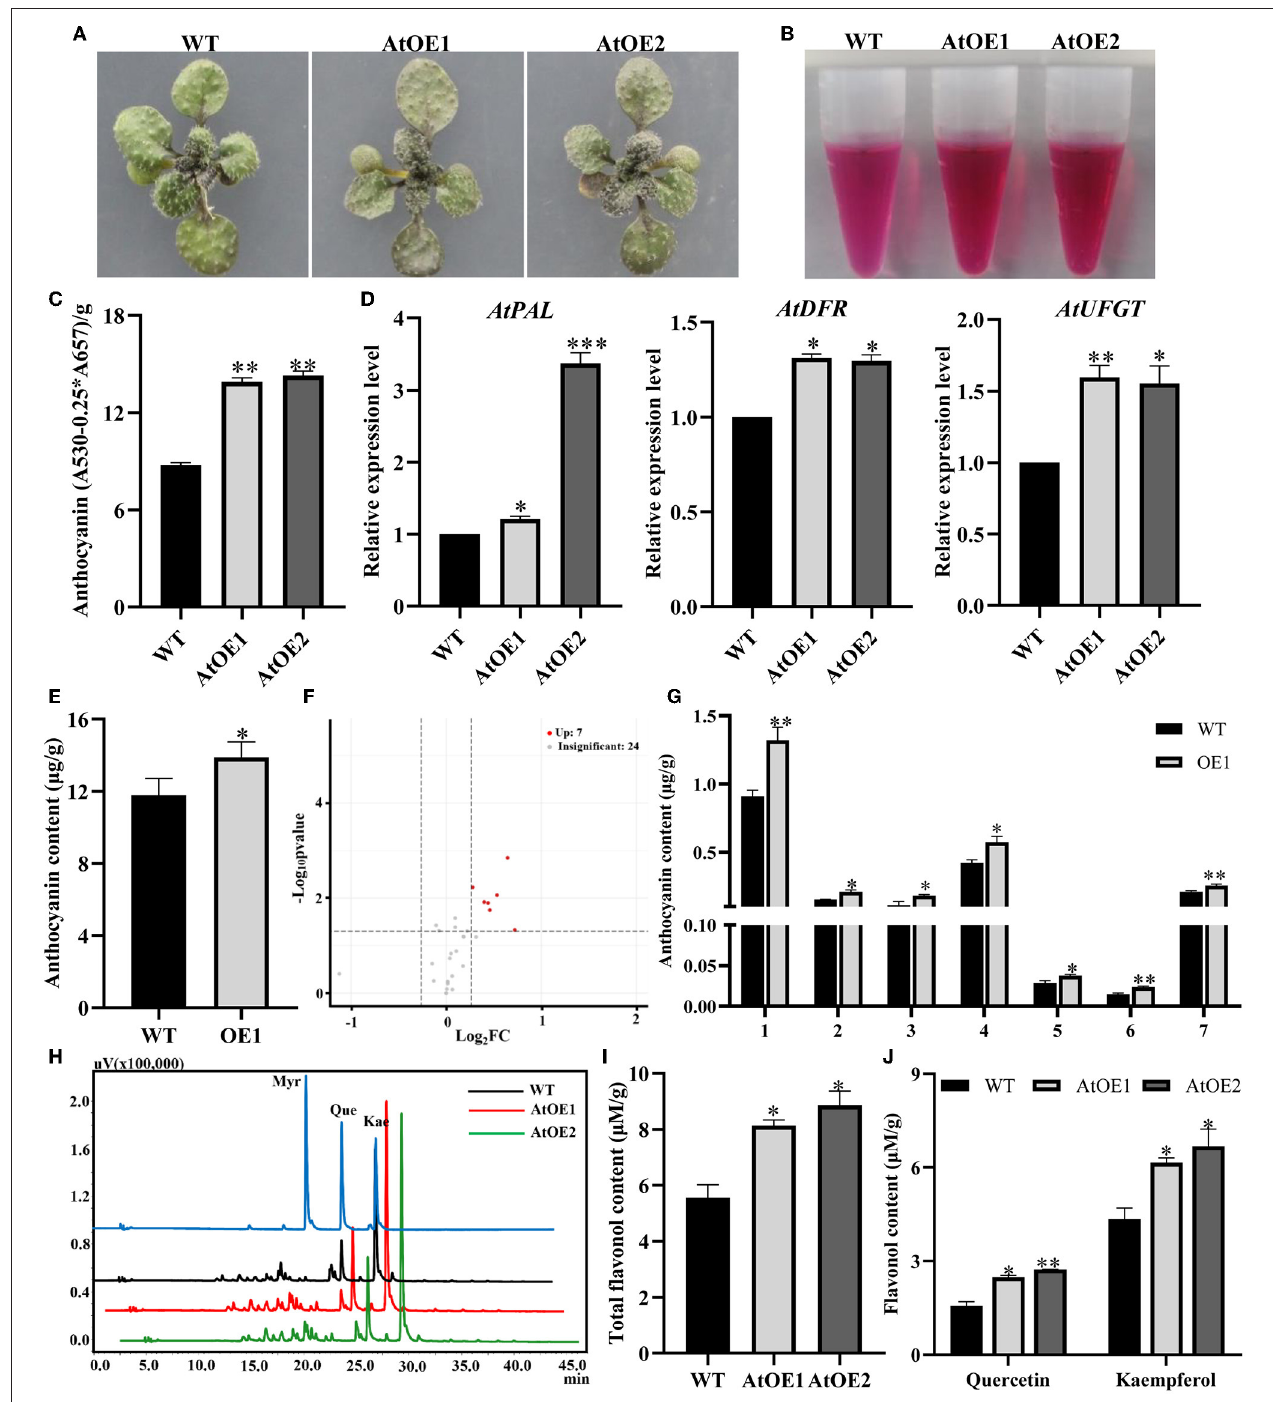
FIGURE 4 | Pn2-ODD1 enhanced the accumulation of anthocyanins and flavonols in 17-day-old Arabidopsis seedlings induced by sucrose. (A) Anthocyanin accumulation visualized by the purple coloration in 17-day-old seedlings induced by sucrose (cultured on a medium containing 3% sucrose for 14 days, then transferred to 12% sucrose medium for 3 days). (B,C) Anthocyanin extraction solutions and anthocyanins contents (spectrophotometry analysis). (D) Expression levels of genes in anthocyanin biosynthesis pathway in WT and AtOE lines induced by sucrose. (E) The absolute quantitative analyses of total anthocyanins in 17-day-old Arabidopsis seedlings induced by sucrose detected by targeted metabolomics strategy. (F) Volcano plot of samples. It showed the levels of anthocyanins metabolites and the statistical significance of the difference. Each point represents a metabolite. Horizontal ordinate represents the fold change of anthocyanins metabolites between two samples, while p -value means significant difference in statistical analysis. (G) 7 up-regulated anthocyanins metabolites identified in the transgenic Pn2-ODD1 Arabidopsis . 1–7: Cyanidin-3,5-O-diglucoside, cyanidin-3-O-rutinoside,